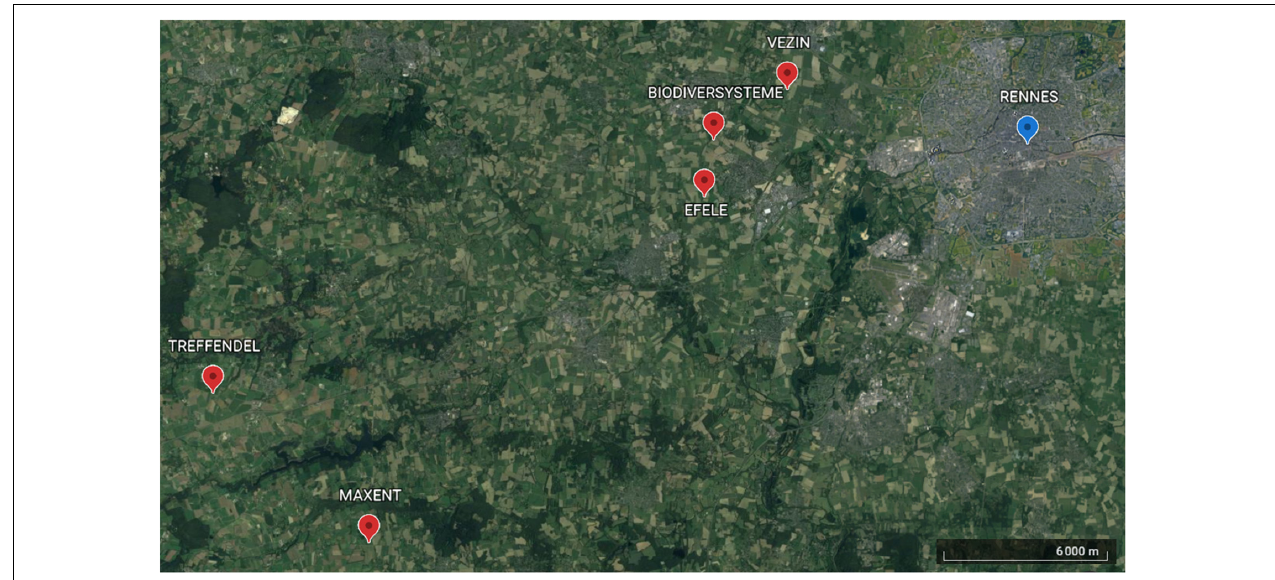
FIGURE 1 | Paired fields location in the vicinity of Rennes, Brittany, Western France.